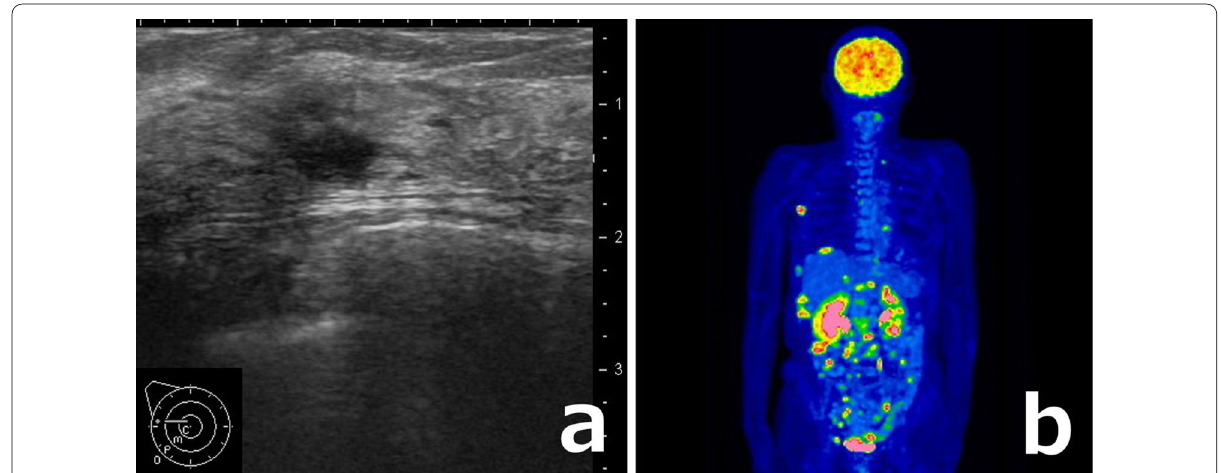
Fig. 1 Case 1: imaging findings. a Ultrasound revealed a low-echo area of approximately 5 mm in the upper-outer quadrant of the right breast. b Positron emission tomography–computed tomography showed numerous foci of dissemination and lymphadenopathy in the abdominal cavity, including the intestine directly under the artificial anus, the right lumbar subcutaneous region, and the right uterine